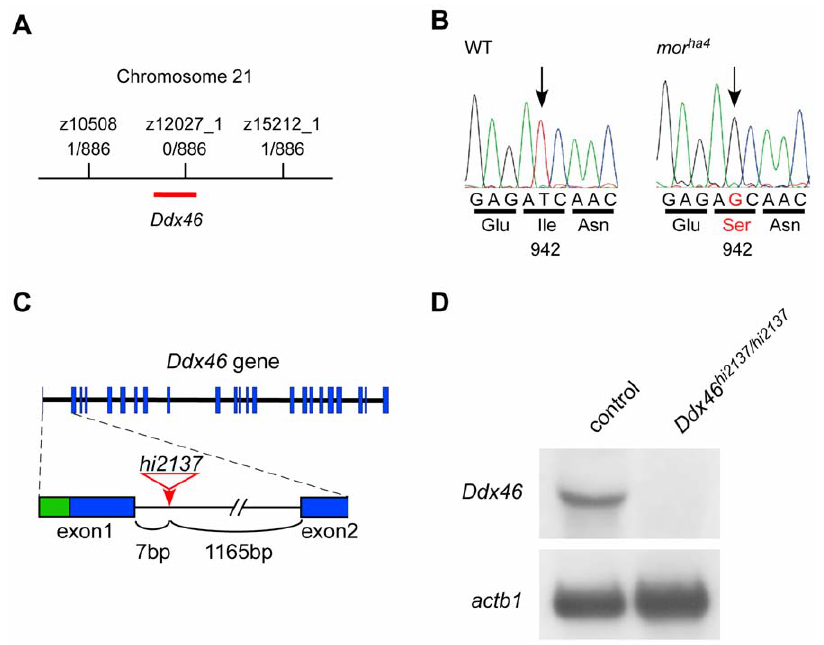
Figure 2. Identification of the mor gene and analysis of the hi2137 allele. (A) Meiotic and physical map schematic of the mor locus on chromosome 21. The number of recombinants and larvae genotyped is shown for each microsatellite marker. (B) Sequencing cDNA from WT and mor ha4 larvae revealed a nucleotide exchange from T to G, which resulted in an Ile-to-Ser transition at amino acid 942 in the mor ha4 mutant. (C) Genomic structure of the Ddx46 gene showing the viral insertion site in the hi2137 allele (red). Exons are boxes, with coding and non-coding sequences in blue and green, respectively. The viral insertion (red arrow) occurs in the first intron between exons 1 and 2. (D) Northern blot analysis of Ddx46 hi2137/hi2137 mutants and control larvae at 3.5 dpf. No Ddx46 transcript was found in the Ddx46 hi2137/hi2137 mutants, whereas the level of actb1 transcript in the mutants was the same as that in control larvae. Control larvae were sibling WT or Ddx46 hi2137/ + larvae and had normal phenotypes.